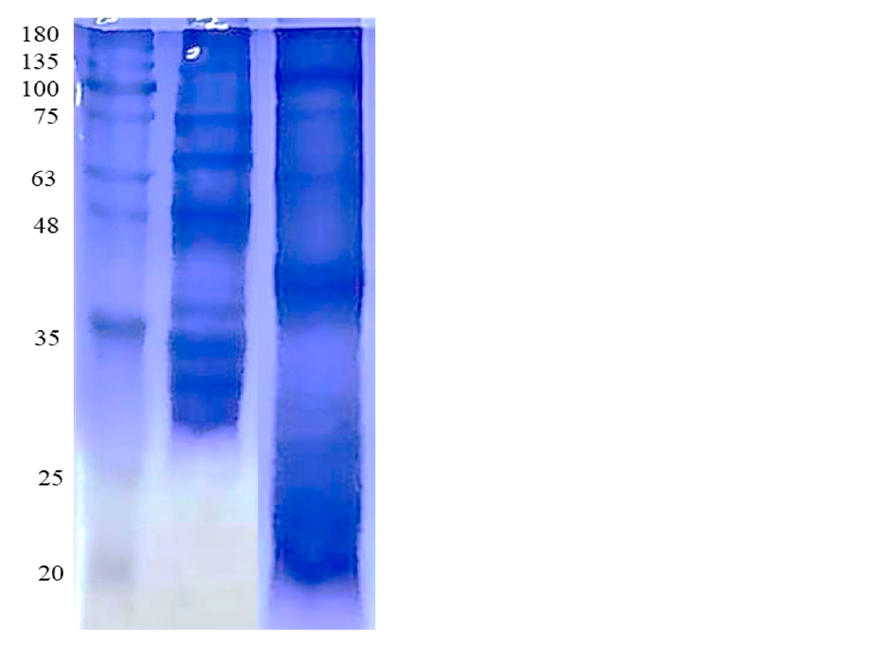
Figure 1. SDS–PAGE of mung bean protein (MNP) (lane 1) and fenugreek protein (FNP) (lane 2) compared to protein standard